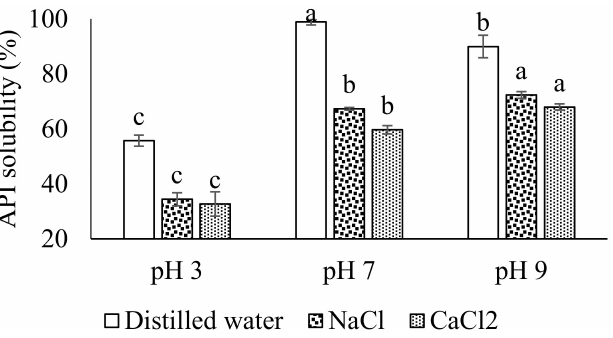
Figure 1. Solubility profile of API at different pH mediums in distilled water and in the presence of NaCl and CaCl 2 . Different letters (a–c) represent significant differences among data. The significant difference was calculated individually among each treatment.